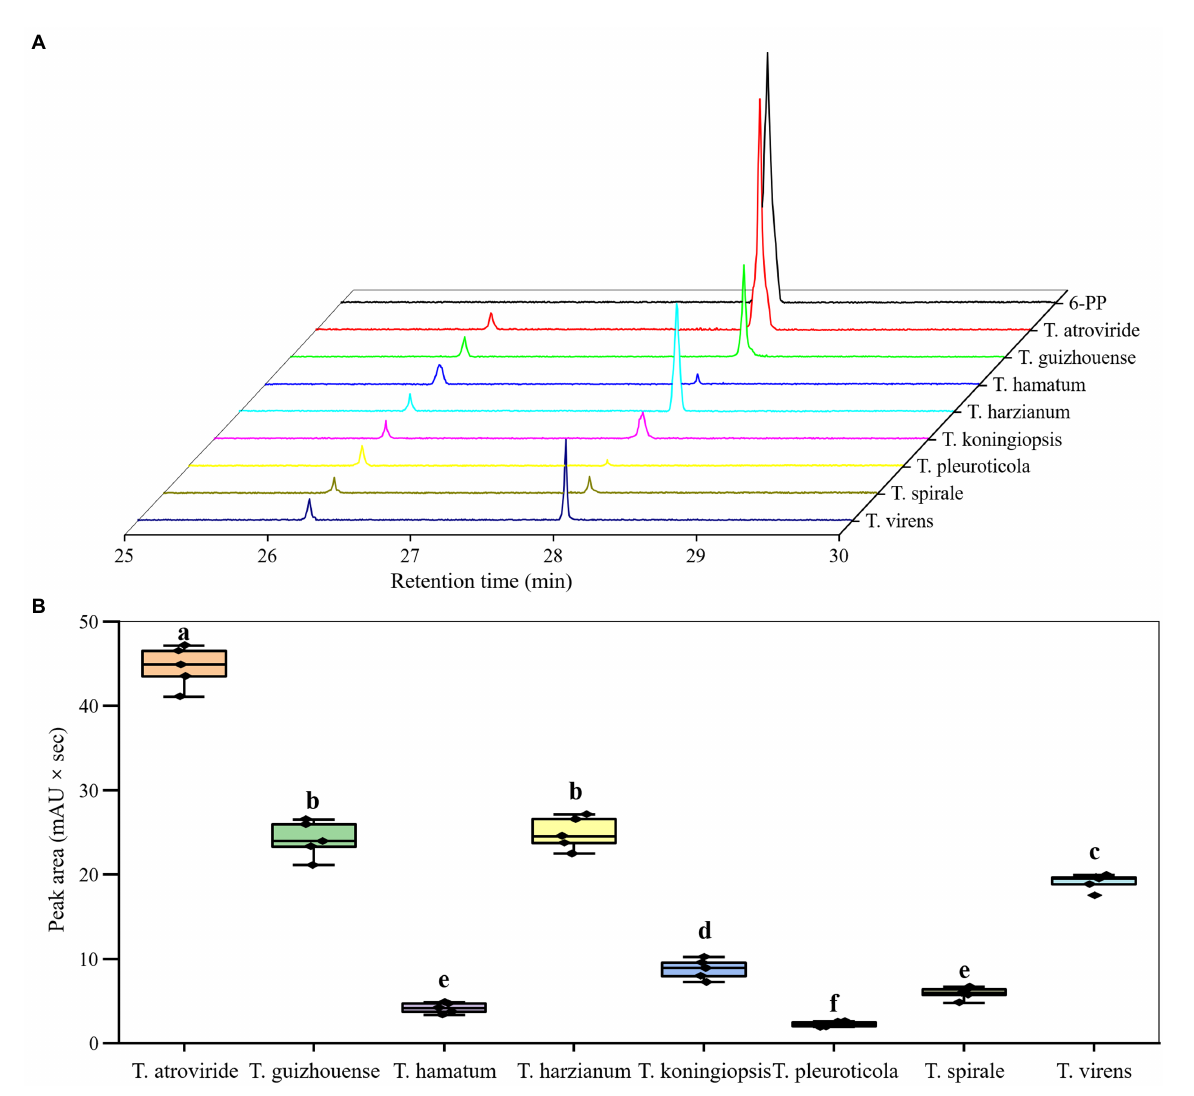
FIGURE 8 Production of 6–pentyl–2H–pyran–2–one (6-PP) by different Trichoderma species. (A) SPME–GC–MS profiles of the fungal volatiles produced by different Trichoderma species. (B) Difference peak areas of 6–PP from different Trichoderma species. Data represent the mean of three independent replicates. Significant differences ( p < 0.05) between means are indicated by different